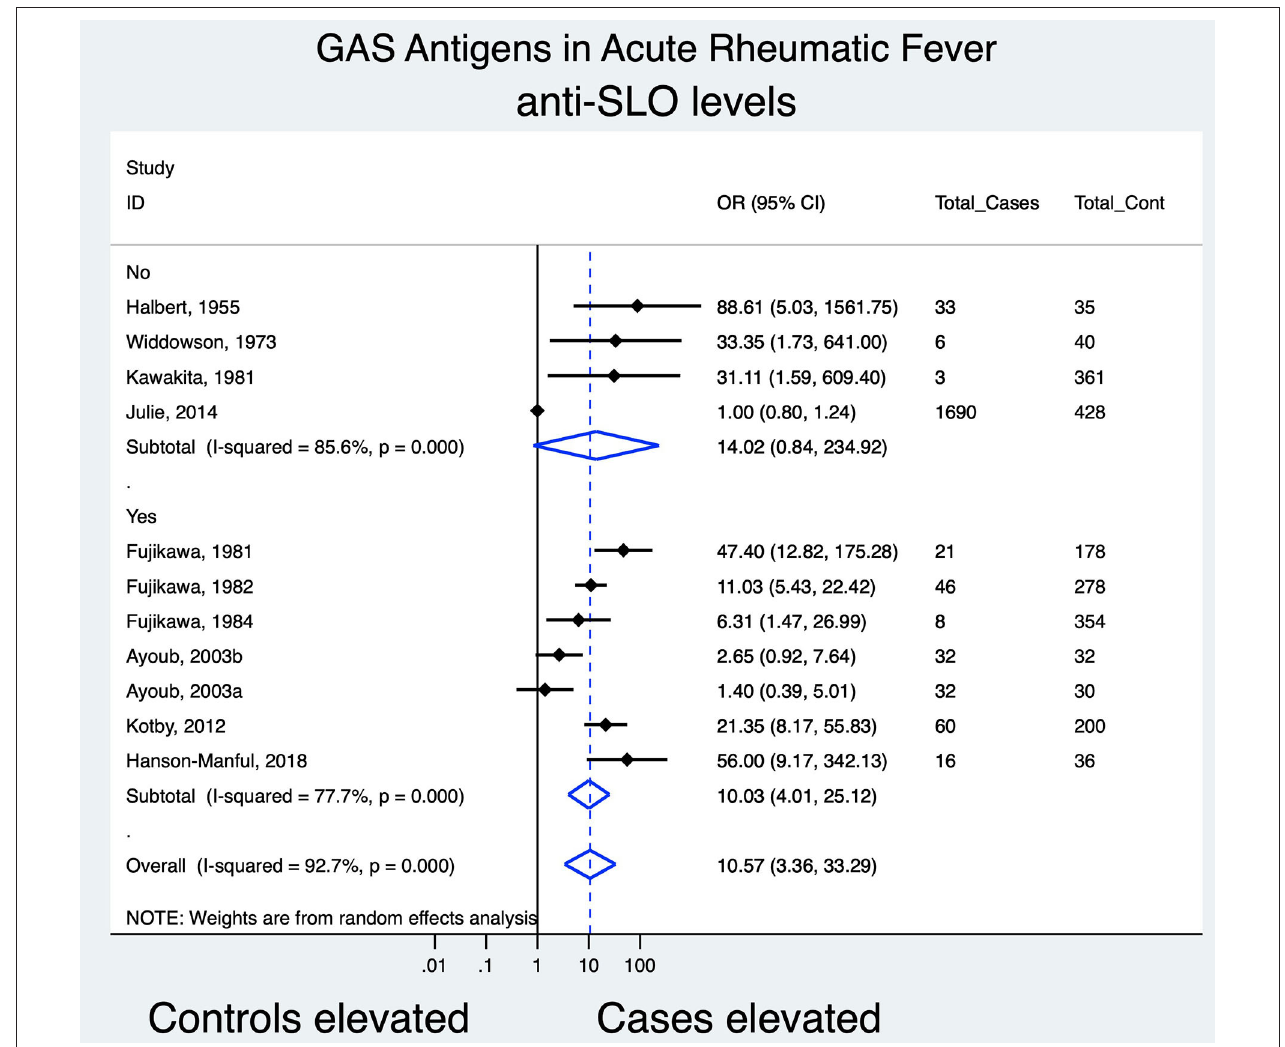
FIGURE 2 | Forest plot evaluating the odds of association between anti-SLO titers and ARF; subgrouping based on whether a guideline was used to diagnose ARF